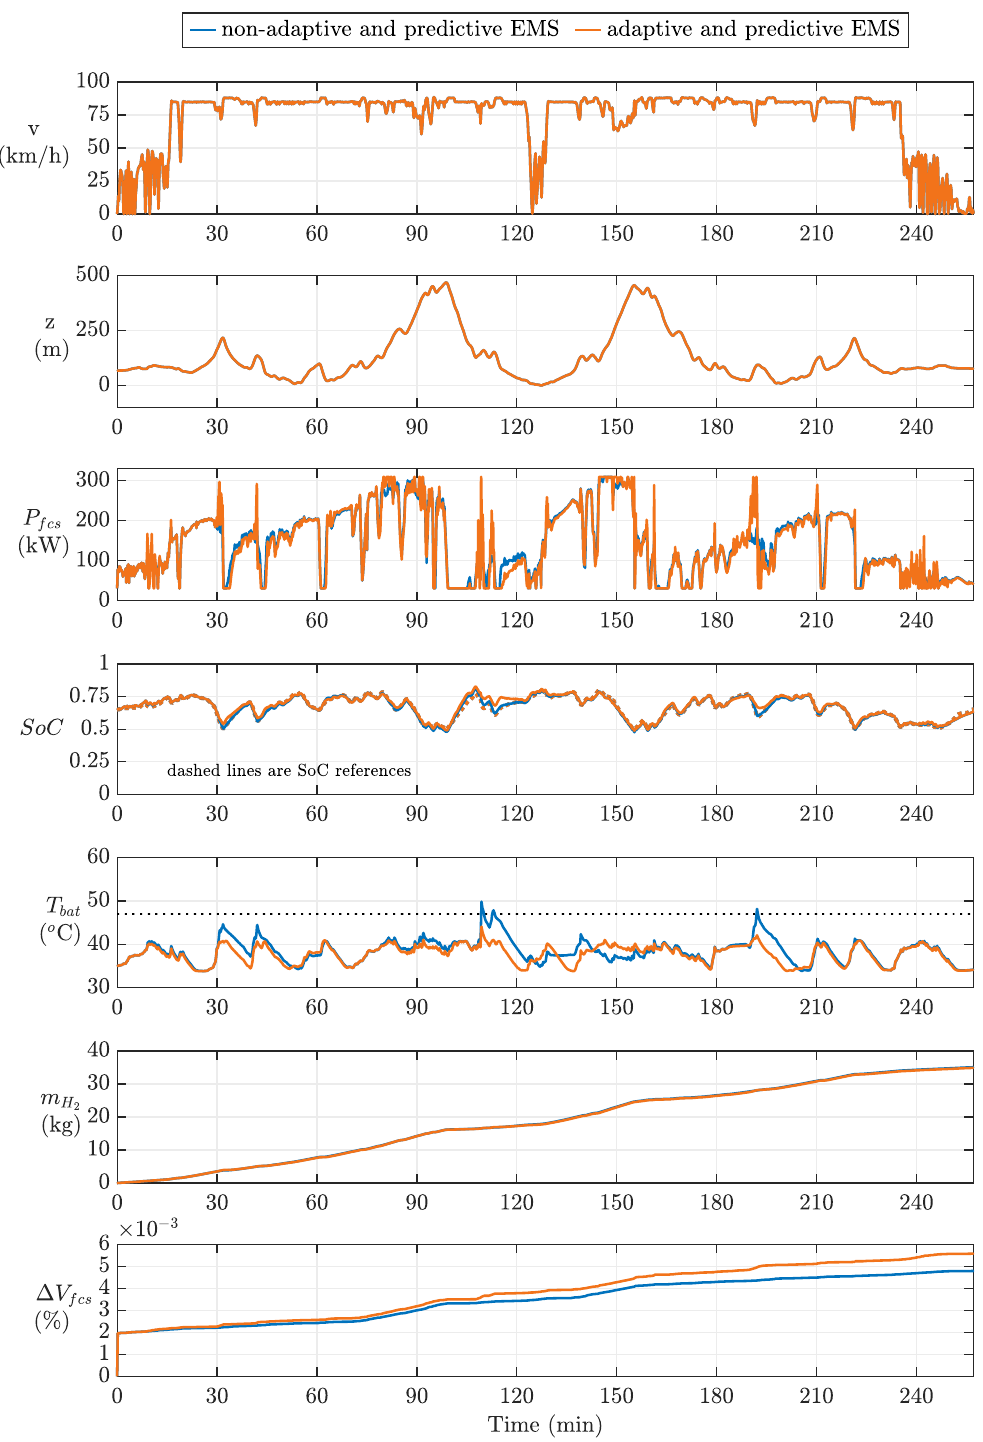
Figure 11. Simulation results comparison between adaptive and non-adaptive EMSs in terms of speed, elevation, fuel cell system power, state of charge, battery temperature, hydrogen consumption, and fuel cell voltage degradation. The ambient temperature is 20 ◦